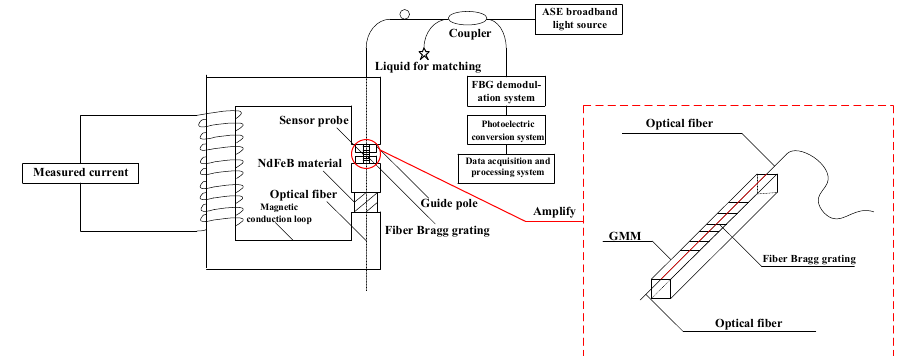
Figure 7. The overall structures of the traditional fiber grating current sensor and the senor probe composed of only FBG and GMM. The magnetic conduction loop is constructed of ferrite material and the sensor probe. The sensing system is composed of a magnetic circuit system established by a magnetically conductive material and a guide pole. The NdFeB material provides the required bias magnetic field. The ASE broadband light source is used as the incident source in this sensor. The coupling ratio of the coupler is 50:50.